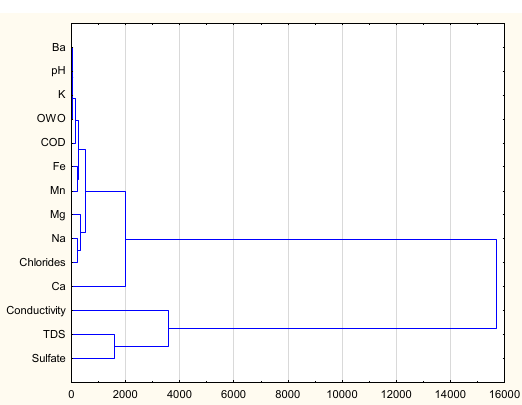
Fig. 2. Cluster analysis of selected parameters of water from piezometers from the waste management